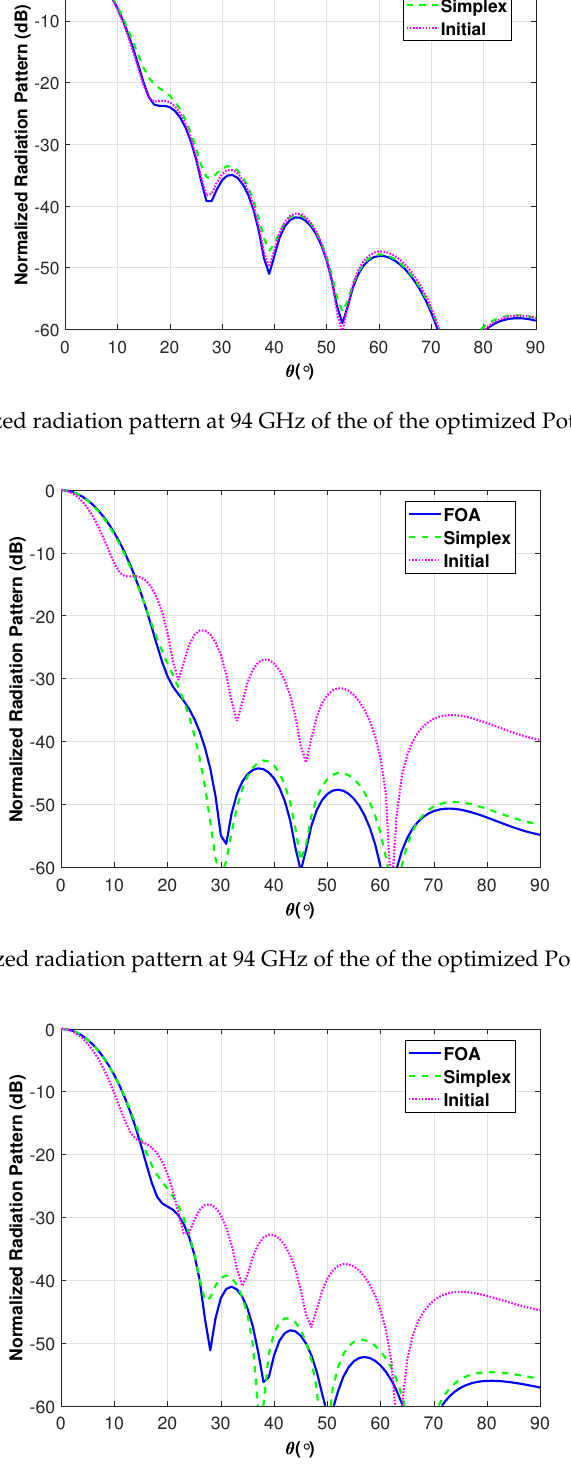
Figure 9. Normalized radiation pattern at 94 GHz of the of the optimized Potter Horn (Diagonal Plane, Copolar